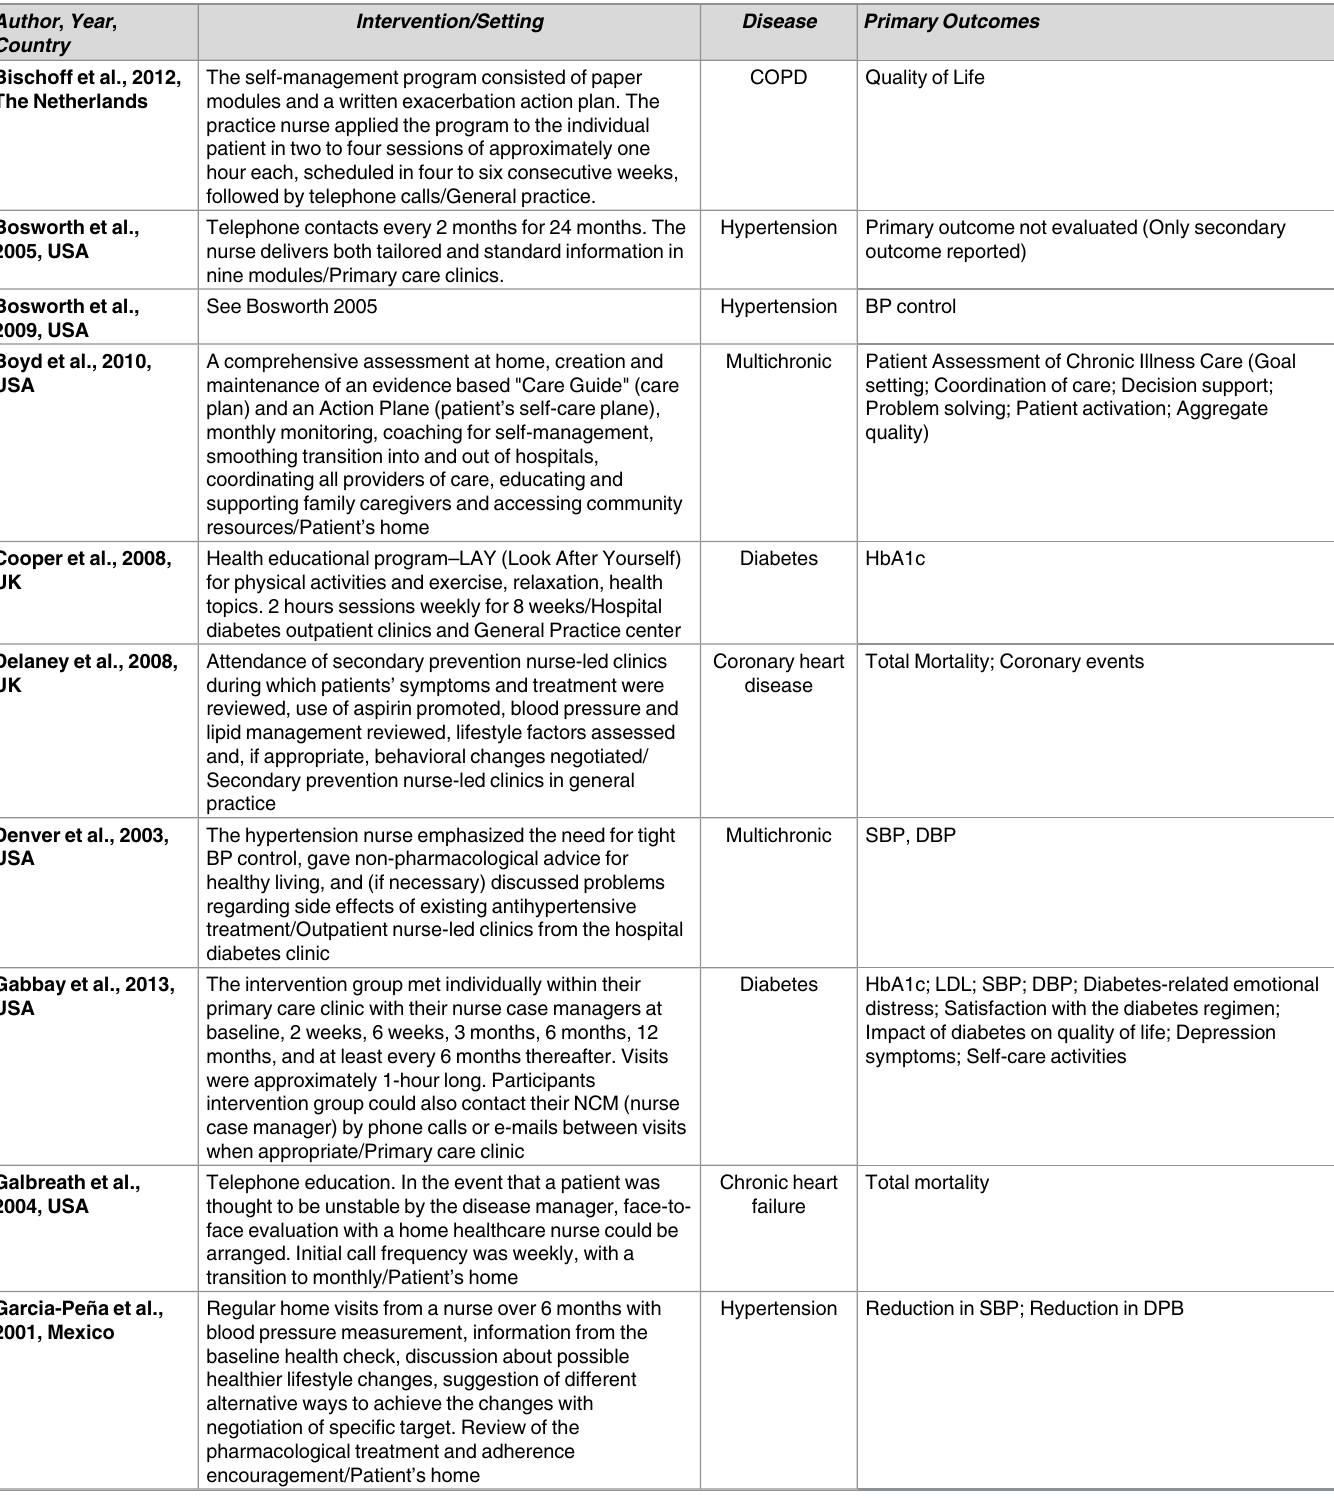
Table 2. Summarycharacteristics of the intervention of included